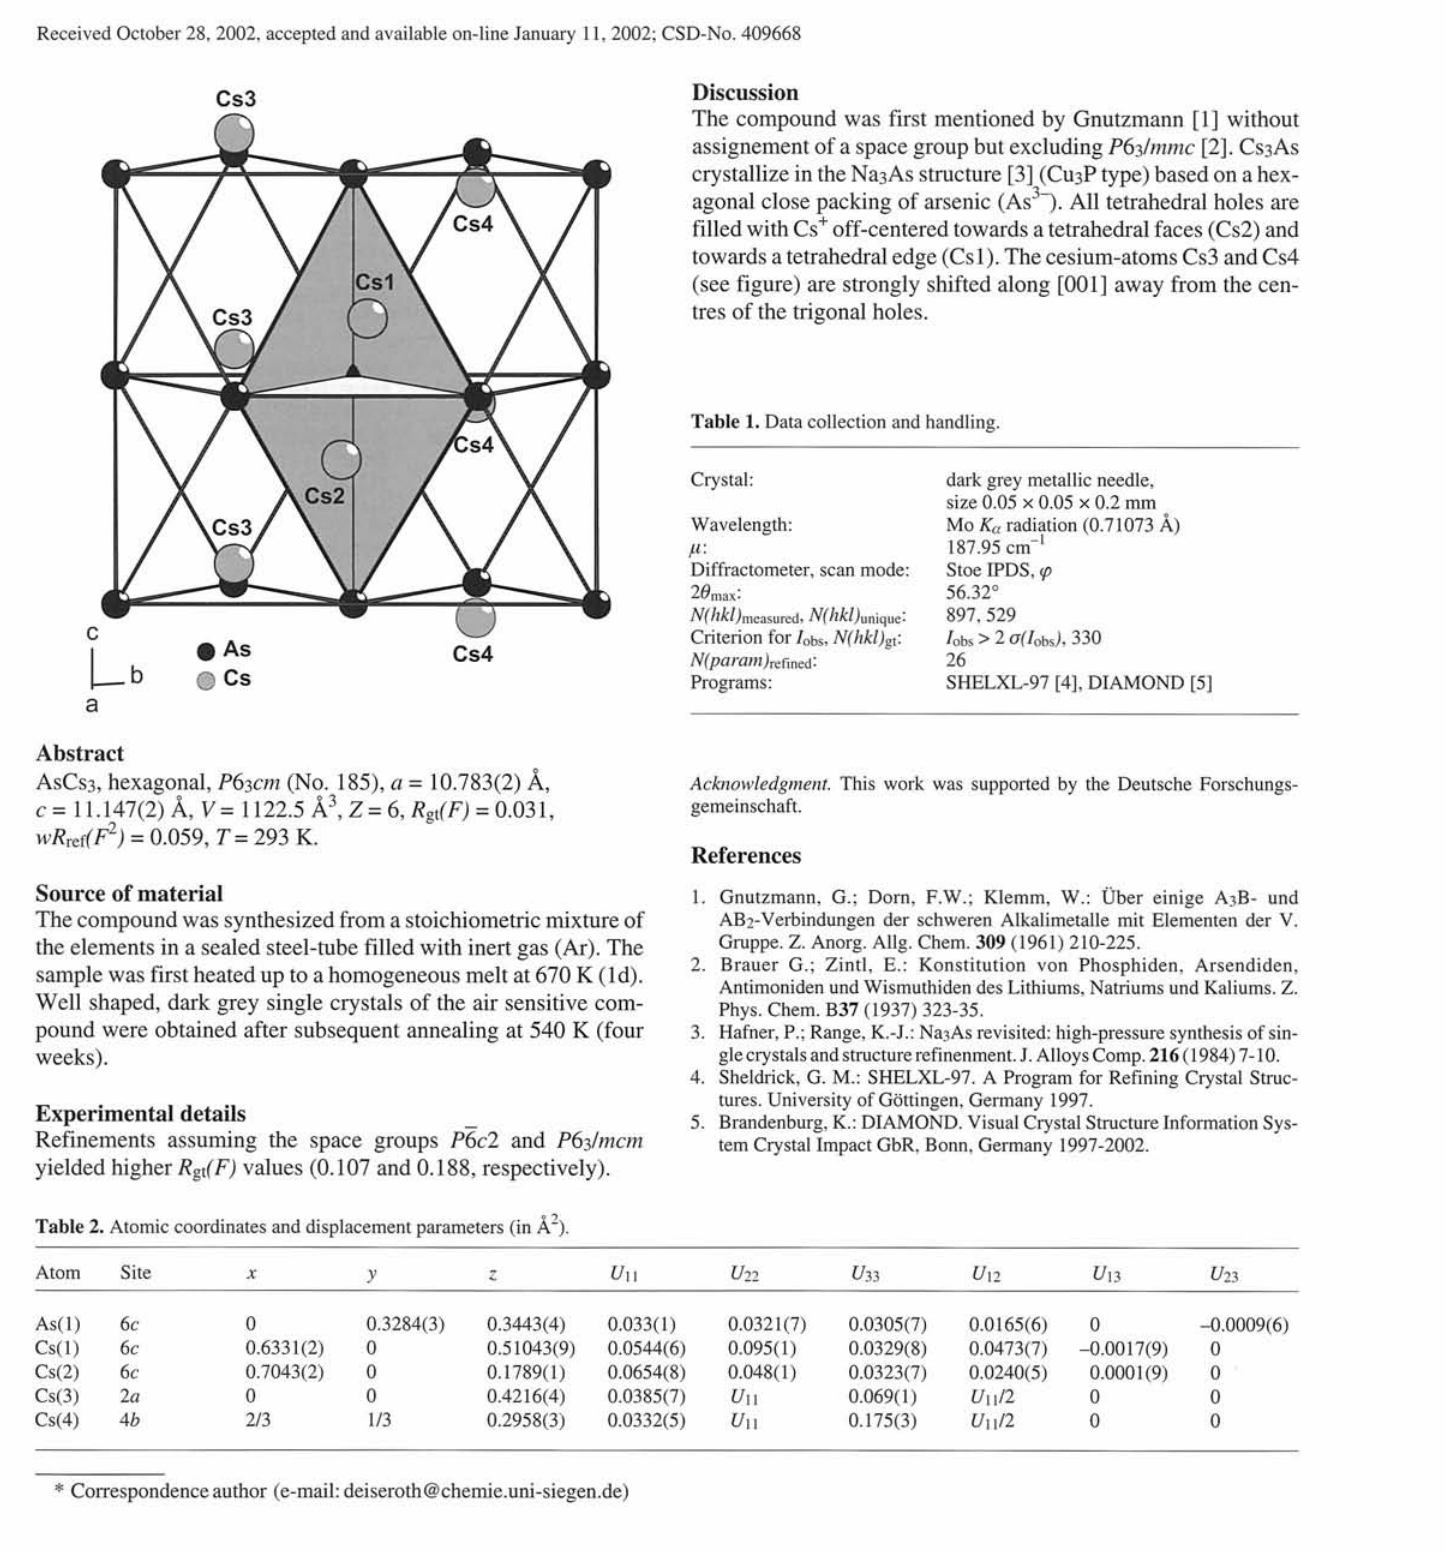
Table 2. Atomic coordinates and displacement parameters (in Á 2 ).